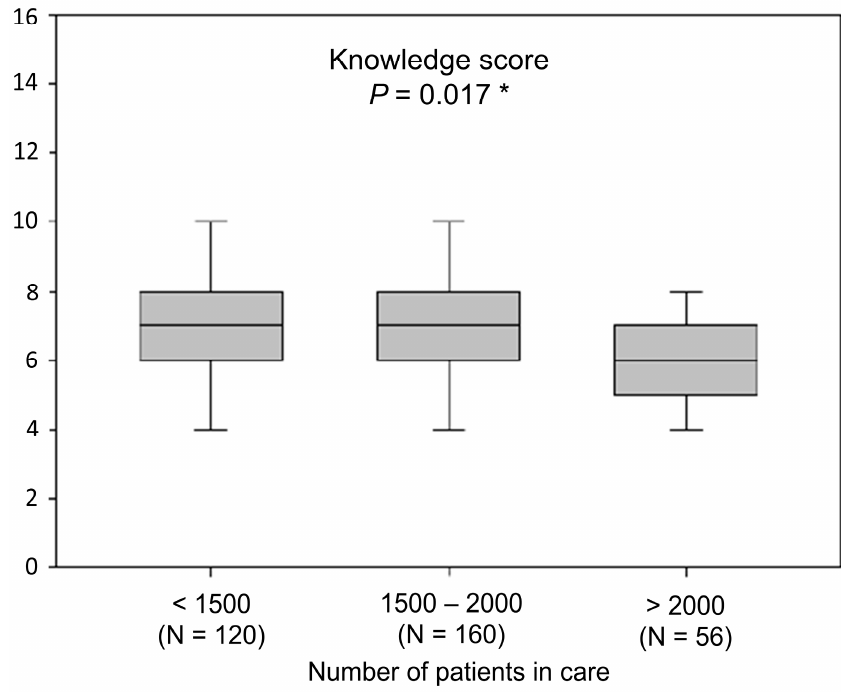
Figure 2. Knowledge score relative to the number of patients in care. * Kruskal–Wallis with post-hoc Conover test. Data are presented as median (interquartile range). Table 4. Physicians who answered correctly to questions related to asymptomatic hyperuricemia and